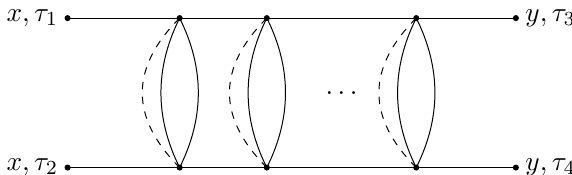
Figure 11. Ladder diagrams connecting two sites far apart. To connect two sites with distance n = j x (cid:0) y j , one need at least n ladders. And the four-point function includes all possible such diagrams and the partner terms with ( (cid:28) 3 $ (cid:28) 4